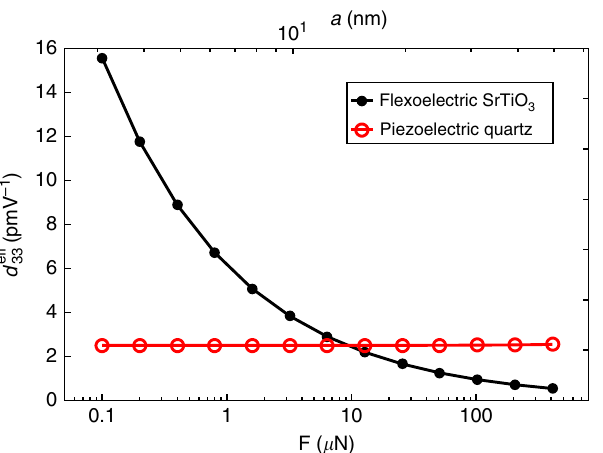
Fig. 3 Effective piezoelectric coef fi cient as a function of contact radius a and force F . The fl exoelectric response is obtained for non-piezoelectric SrTiO 3 (STO) considering only fl exoelectricity (both direct and converse). For comparison, we show the hypothetical response of an archetypal piezoelectric (quartz) assuming an absence of fl exoelectricity. The contact radius is obtained under the applied force, in the absence of the tip voltage. The fl exoelectric response shows a size-dependent behaviour which can be used as a means to qualitatively distinguish between fl exoelectricity and